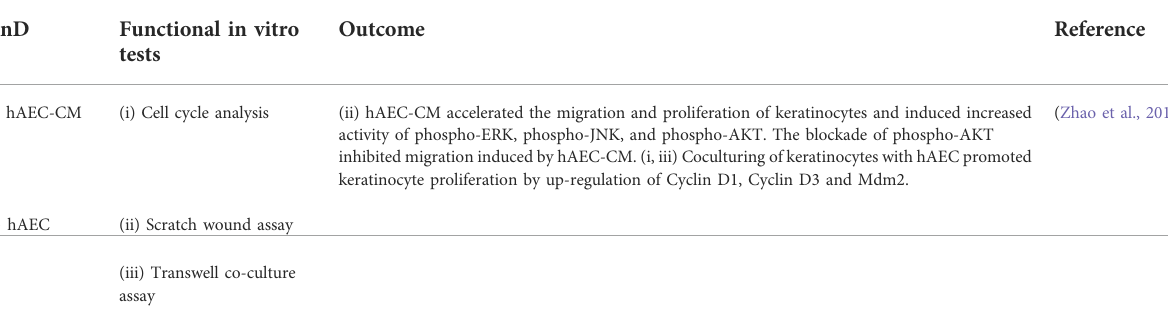
Abbreviations:bFGF:basic fi broblastgrowthfactor,CAM:chickchorioallantoicmembrane,CM:conditionedmediumderivedfromhAEC,hAMSC,hPMSC,hUC-MSC,hUC-MSC-End, EGF:epidermalgrowthfactor,HaCAT:immortalizedhumankeratinocytes,hAEC:humanamnioticmembraneepithelialcells,hAMSC:humanamnioticmembranemesenchymalstromal cells,HDF:humandermal fi broblastshPMSC:humanplacentamesenchymalstromalcells,hUC-MSC:humanumbilicalcordmesenchymalstromalcells,hU-MSC-End:humanumbilical cord mesenchymal stromal cells-endothelial transdifferentiated, HUVEC: human umbilical cord vein endothelial cells, IL-1, IL-6: interleukin-1, -6, KDR: kinase insert domain